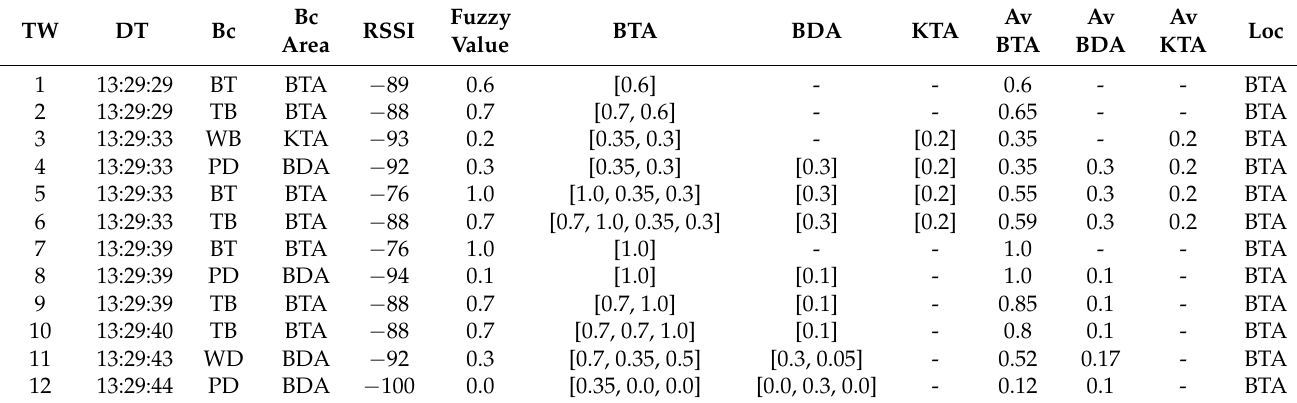
Figure 4. Trapezoidal membership functions for temporal window. To explain the intelligent processing with the proposed fuzzy methodology, a fragment of the UCAmI dataset has been selected (see Table 2), corresponding to the Brush teeth activity carried out by the inhabitant. Table 2. Subset of data corresponding to the Brush teeth